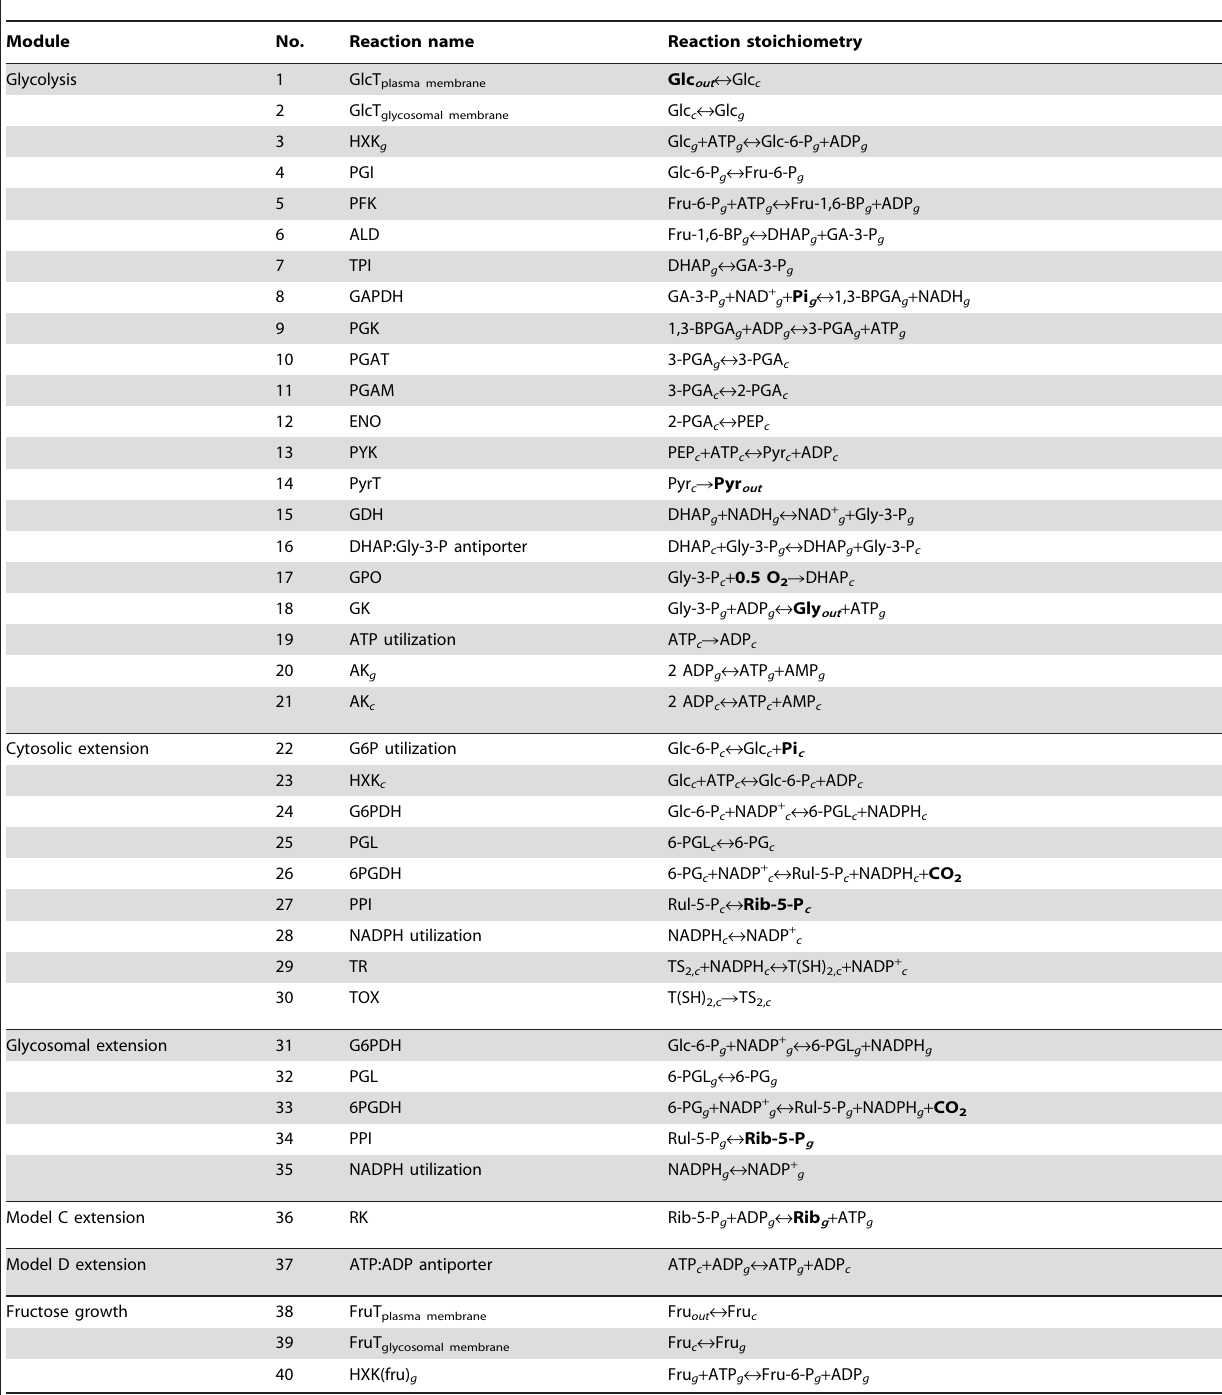
Bold characters indicate external metabolites which are kept fixed. Other metabolites are internal variables of the system.